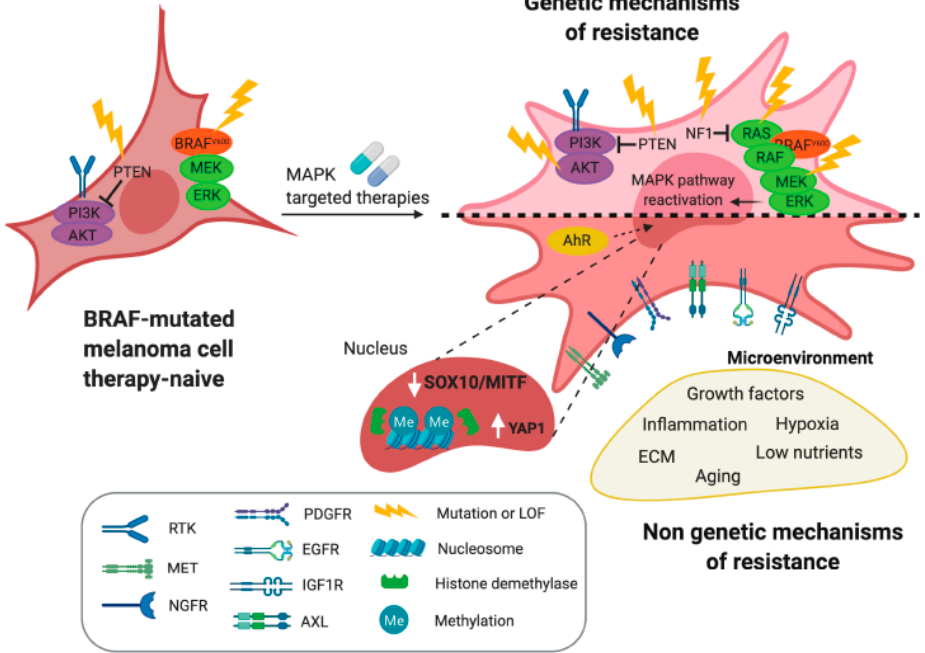
Figure 1. Mechanisms of resistance to mitogen-activated protein kinase (MAPK)-targeted therapies in melanoma. Melanoma cells evade targeted therapies by acquiring additional genetic alterations or through non-genetic mechanisms. LOF: loss of function; MEK: mitogen-activated protein kinase kinase; ERK: extracellular signal-regulated kinase; NF1: neurofibromatosis 1; RTK: receptor tyrosine kinase; MET: hepatocyte growth factor receptor; NGFR: nerve growth factor receptor; PDGFR: platelet derived growth factor receptor; EGFR: epidermal growth factor receptor; IGF1R: insulin-like growth factor 1 receptor; AXL: AXL receptor tyrosine kinase; PTEN: phosphatase and Tensin homolog; PI3K: phosphoinositide 3-kinase; MITF: microphthalmia-associated transcription factor; SOX10: SRY-box transcription Factor 10 (SOX10); YAP1: Yes-associated protein 1; AhR: aryl hydrocarbon receptor.